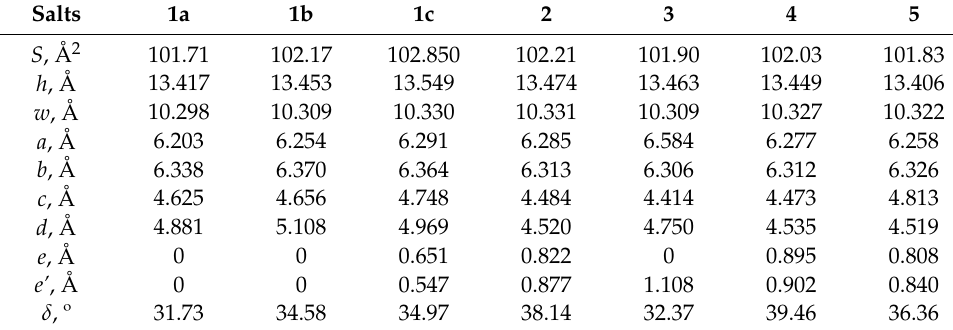
1a = 100 K (triclinic), 1b = 150 K (monoclinic), 1c = 240 K (monoclinic).